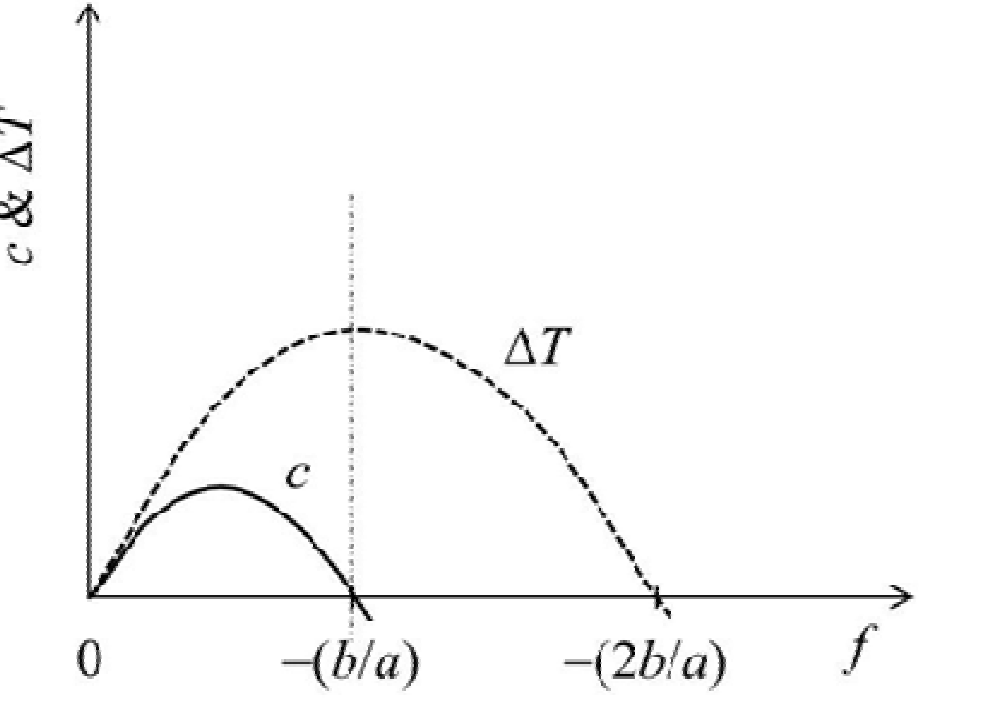
Figure 5. Expected force ( f ) dependence of the coe ffi cient of performance ( c ) and the increment of the transition temperature ( ∆ T ).